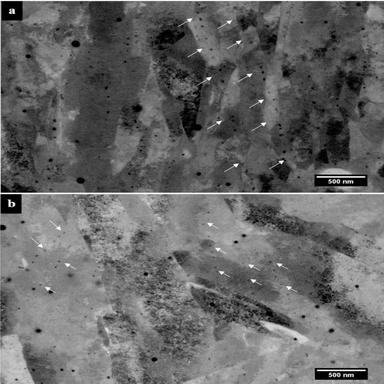
ECCI images of the martensitic microstructure of a H900-4 h sample containing scattered spherical submicrometric particles in a) fine and b) coarse grain regions. Arrows show the alignment of spherical oxide nanoparticles, which indicates the possible location for the solidification cellular walls.